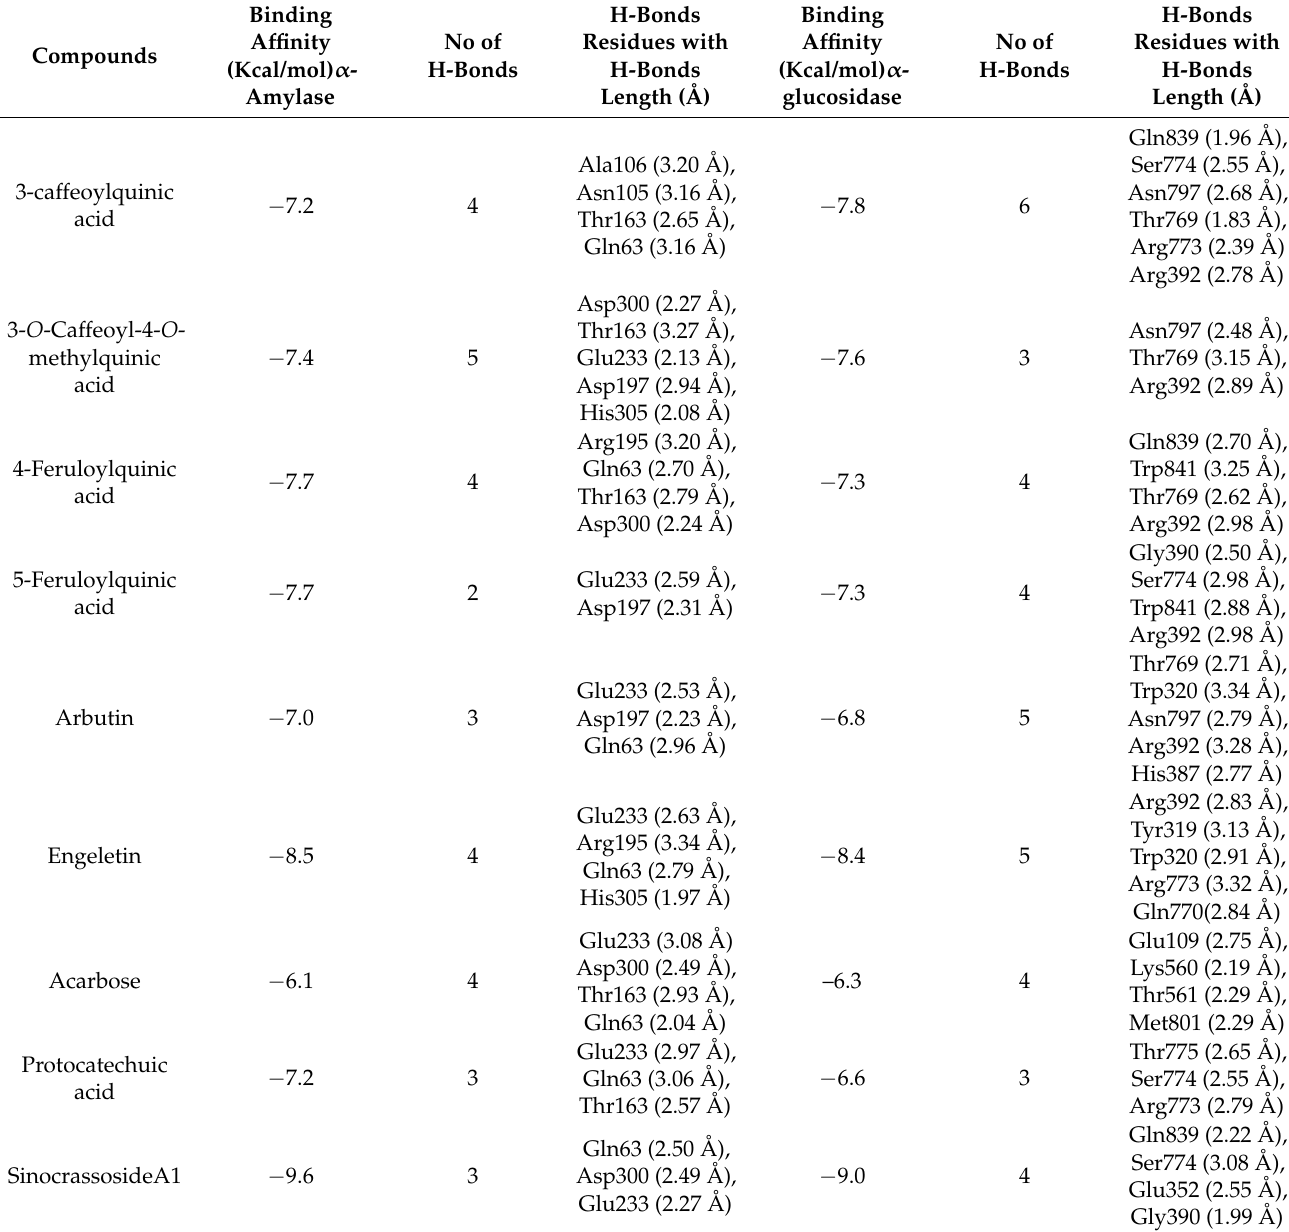
Table 4. Predicted binding affinity and detailed docking interactions of α -amylase and α -glucosidase with compounds of AAHPE and